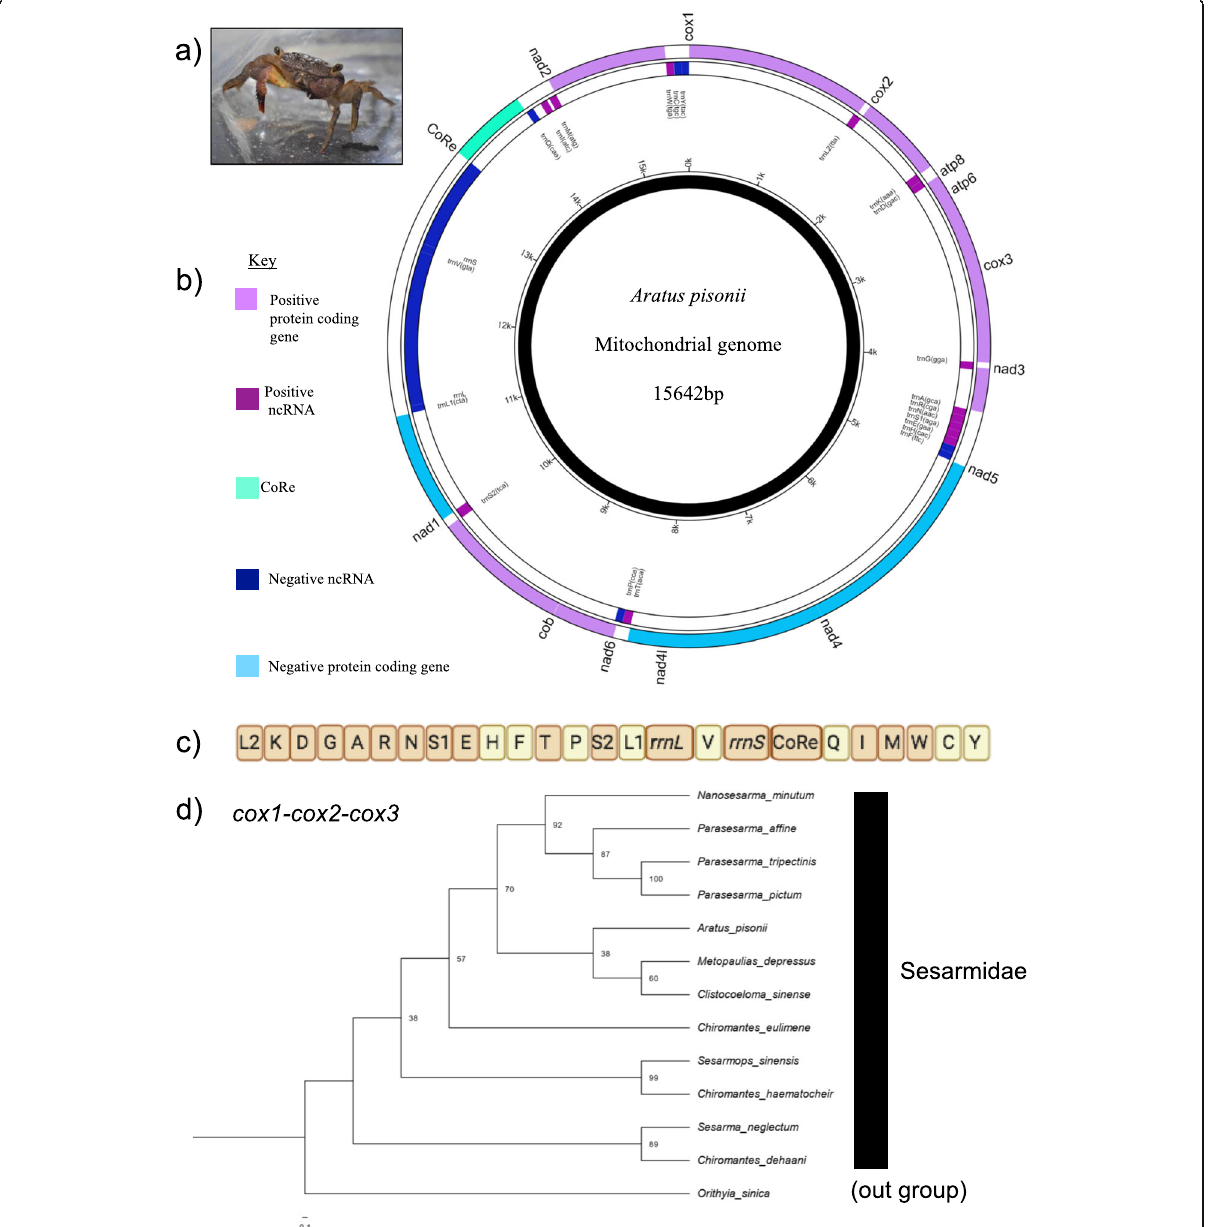
Fig. 5 Annotated circa plot for the circular mitochondrial genome of Aratus pisonii (host image: A ). B The mitochondrial genome is represented by the central circular black line. Protein coding genes are located on the outer edge of the plot. Genes coded on the positive strand are purple, those on the negative strand are blue. Non-coding RNA genes are on the inner most circle of the plot with the same colour coding strategy as for protein coding genes. The control region (CoRe) can be seen in a teal colour. The genome was plotted in Circa (www.omgenomics.com/ circa). C Illustration of the SesGO non-coding gene arrangement is shown, representing the gene arrangement of A. pisonii . Those genes in yellow boxes are encoded on the negative strand and positive in orange. Each tRNA gene is denoted using the one letter abbreviation of the corresponding amino acid. The small and large ribosomal subunits are abbreviated to rrnL and rrnS, respectively. D Maximum-likelihood phylogenetic relationships are presented for 12 Sesarmidae crabs (KU343209, KR336554, KX118277, KX156954, KU589292, NC_038066, NC_039990, NC_040977, NC_041212, NC_042142, NC_047209) and one outgroup (NC_039639) using a concatenated ( cox1-cox2-cox3 ) nucleotide sequence. The model of nucleotide evolution, GTR + F + I + G4, was chosen according to BIC in IQtree including 1000 bootstrap replicates. Additional data are presented in Additional file